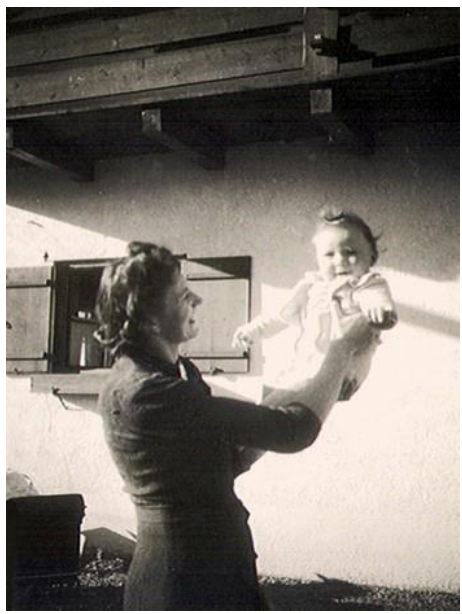
Figure 1. Gisela Heidenreich as a baby with her mother, Emilie Edelmann. Humanities 2018 , 7 , x FOR PEER REVIEW